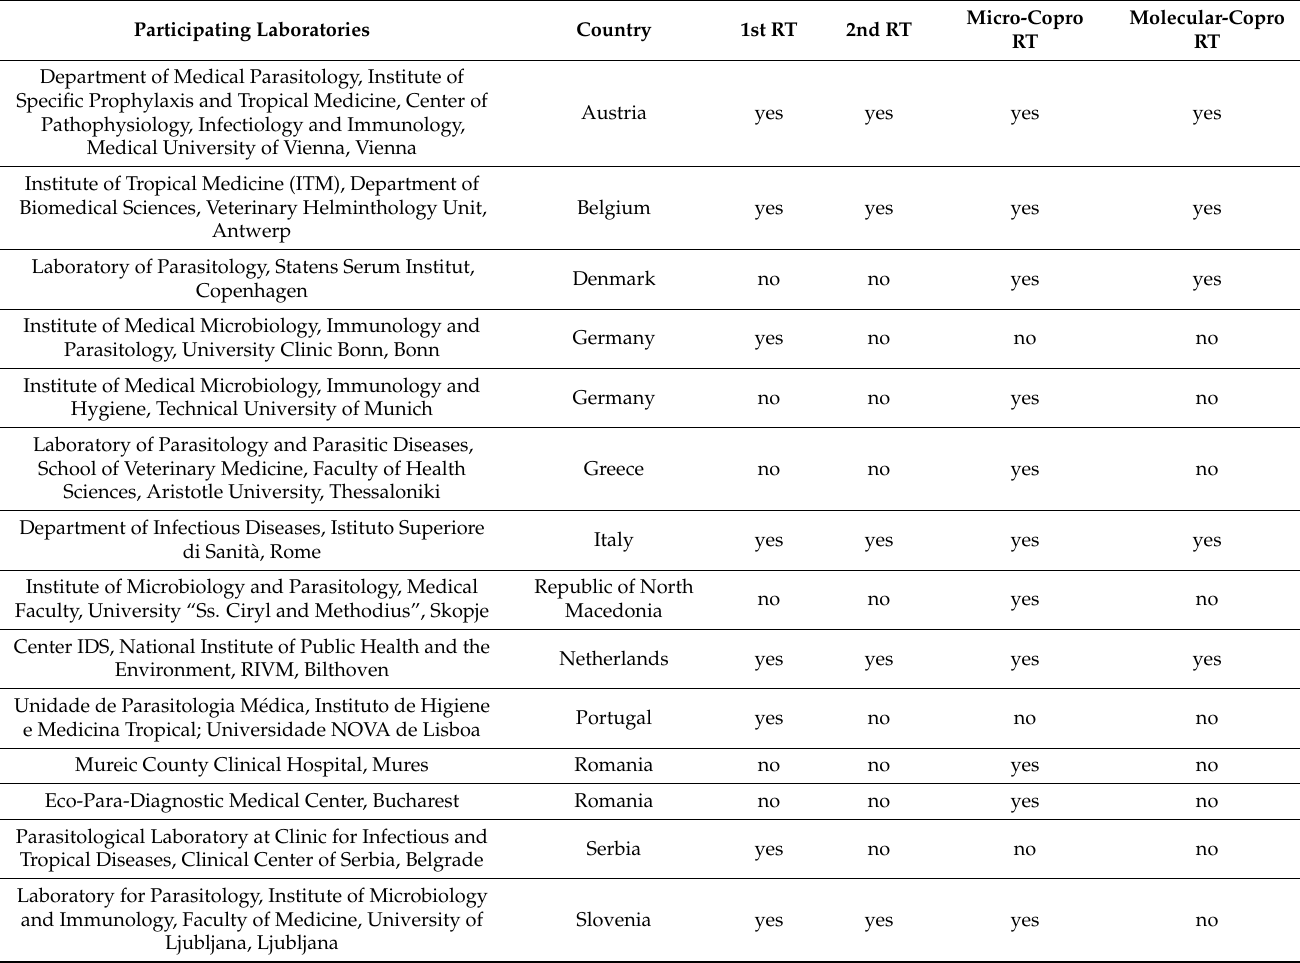
Table 1. Laboratories and countries participating in the Ring Trials